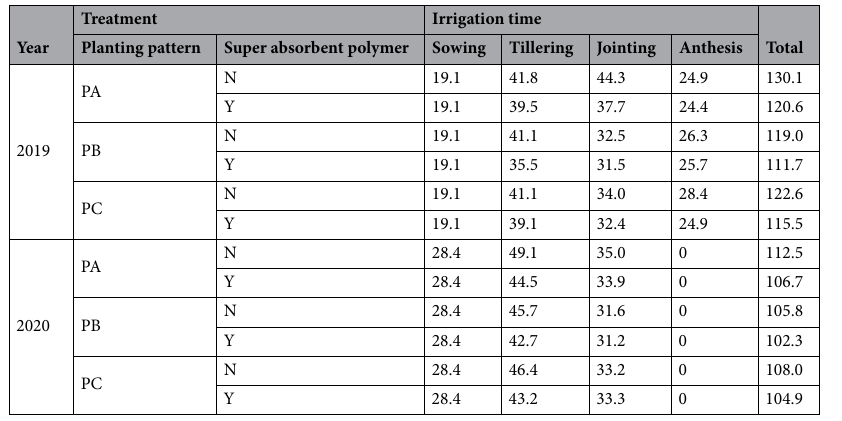
Table 2. Irrigation volumes of different treatments